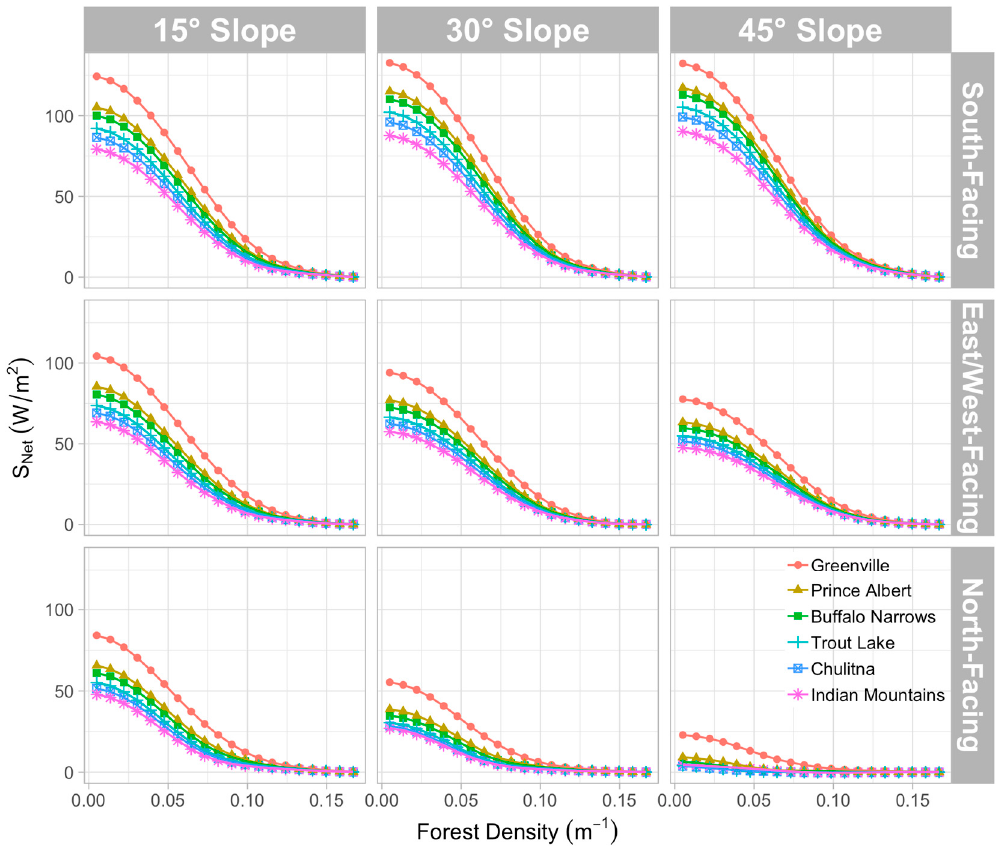
Figure 3. Variations of net shortwave radiation with vegetation density at different sites for different slope angles and aspect of the forested hillslope under clear sky conditions. Legend lists the sites in increasing order of latitude from top to bottom.